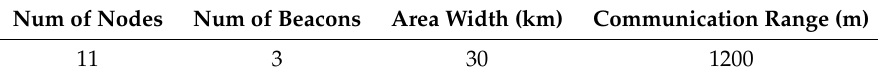
Table 1. Experimental setup.